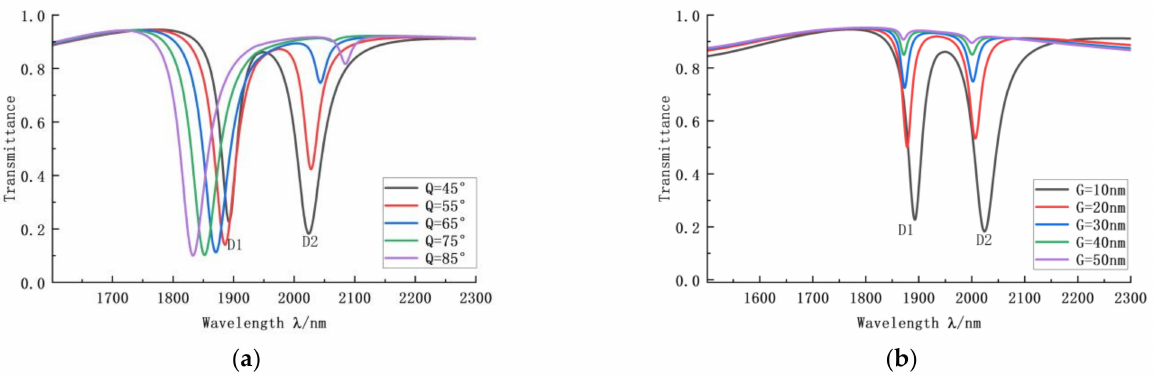
Figure 6. ( a ) Transmission curve spectrum when Q is changed. ( b ) Transmission curve spectrum when G is